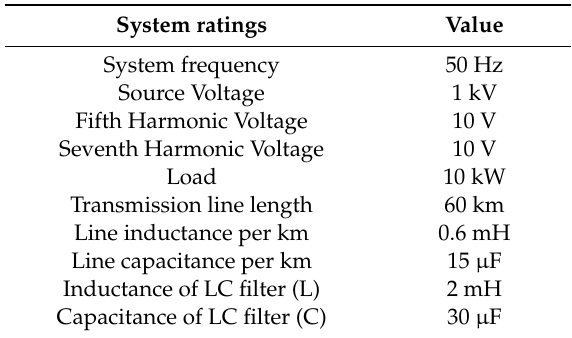
Table 2. Transmission System Parameters.